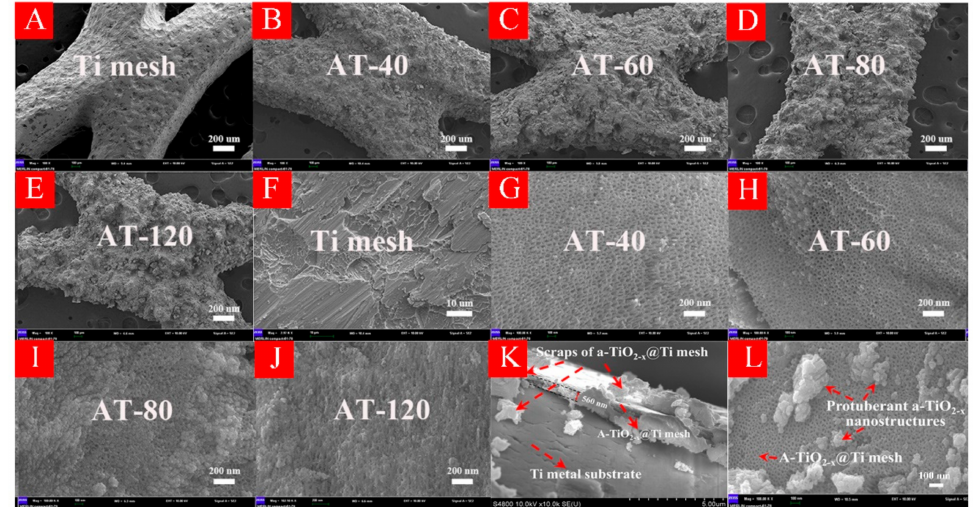
Figure 3. ( A – L ) display scanning electron microscopy (SEM) images of all HA-TiO 2 − x samples. ( K ) shows the cross-section SEM image of AT-60. ( L ) shows some protuberances generated on Ti mesh